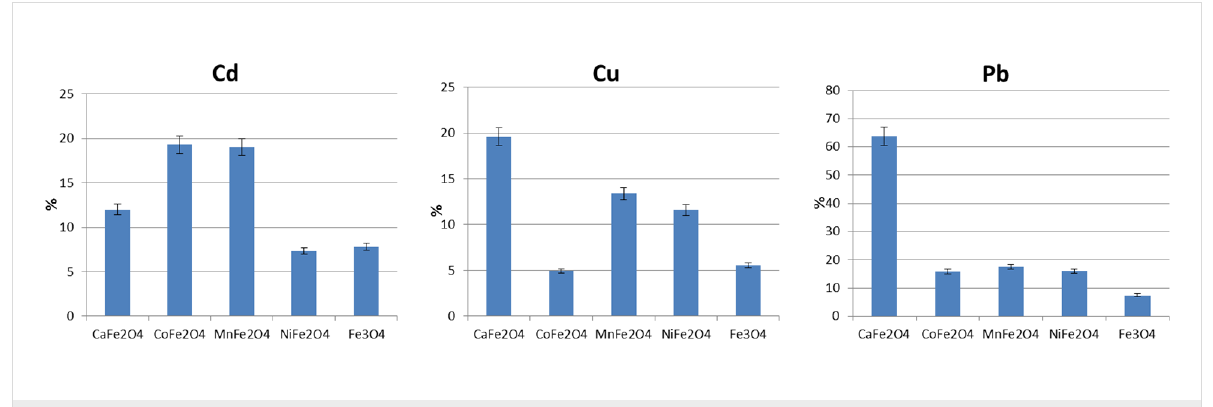
Figure 7: EDX measurements of different types of nanoparticles after exposure to Cd, Cu and Pb solutions.